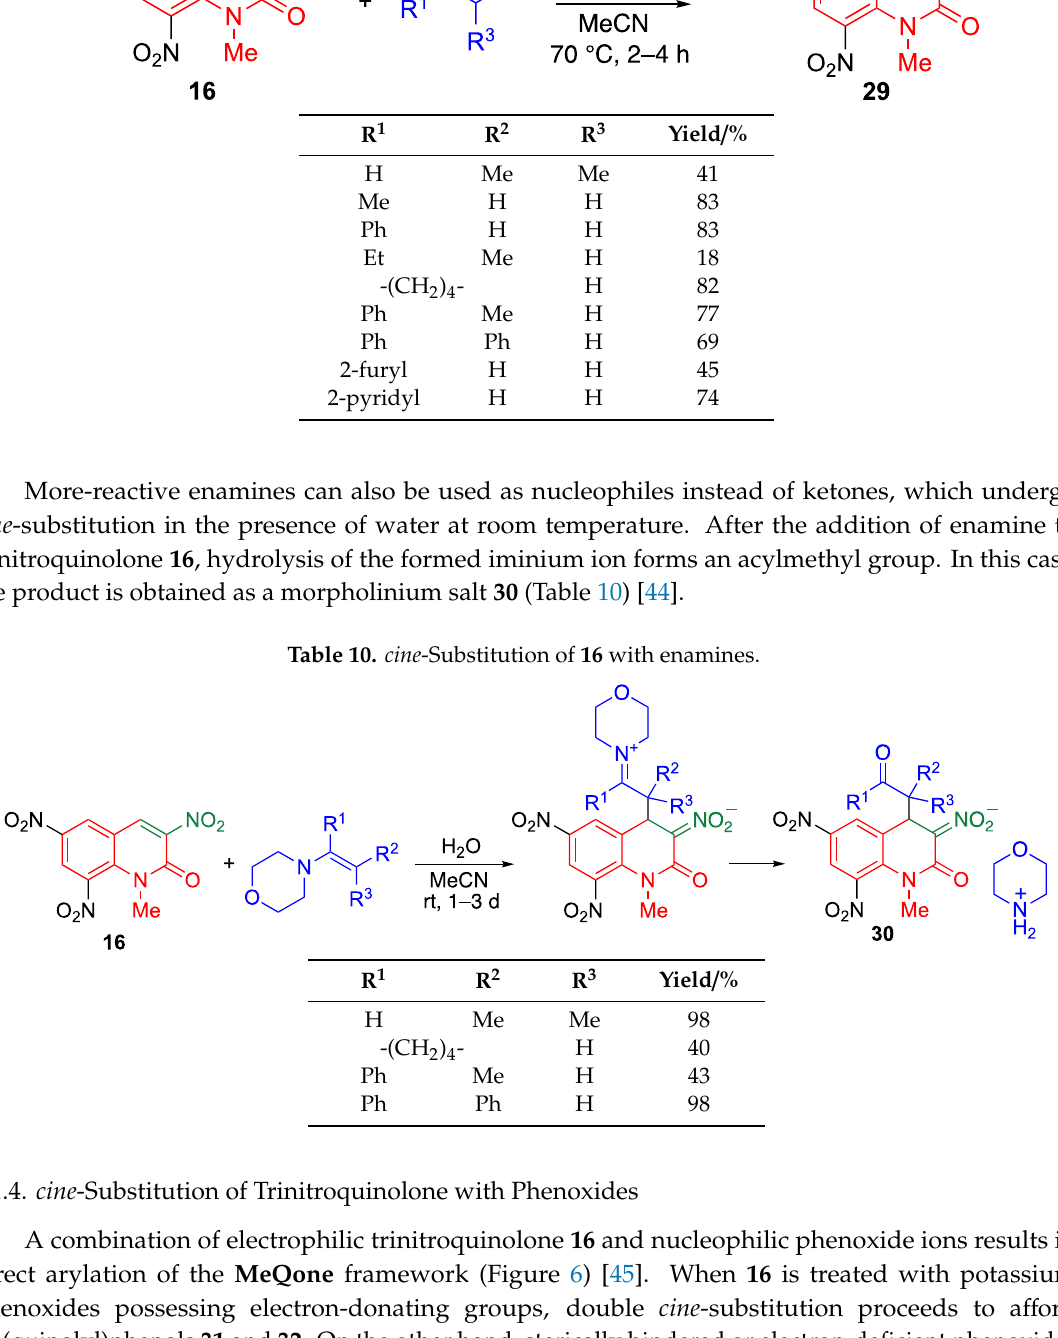
Table 9. cine -Substitution of 16 with ketones.